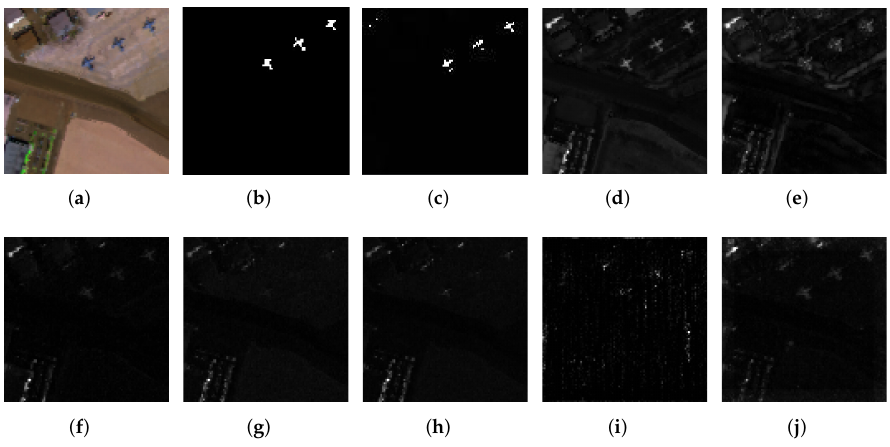
Figure 6. Visual detection results of all the algorithms on the San Diego dataset. ( a ) Pseudocolor image. ( b ) Ground-truth. ( c ) BEGAIP. ( d ) LRASR. ( e ) GTVLRR. ( f ) LSMAD. ( g ) RX. ( h ) RPCA. ( i ) LRX. ( j )